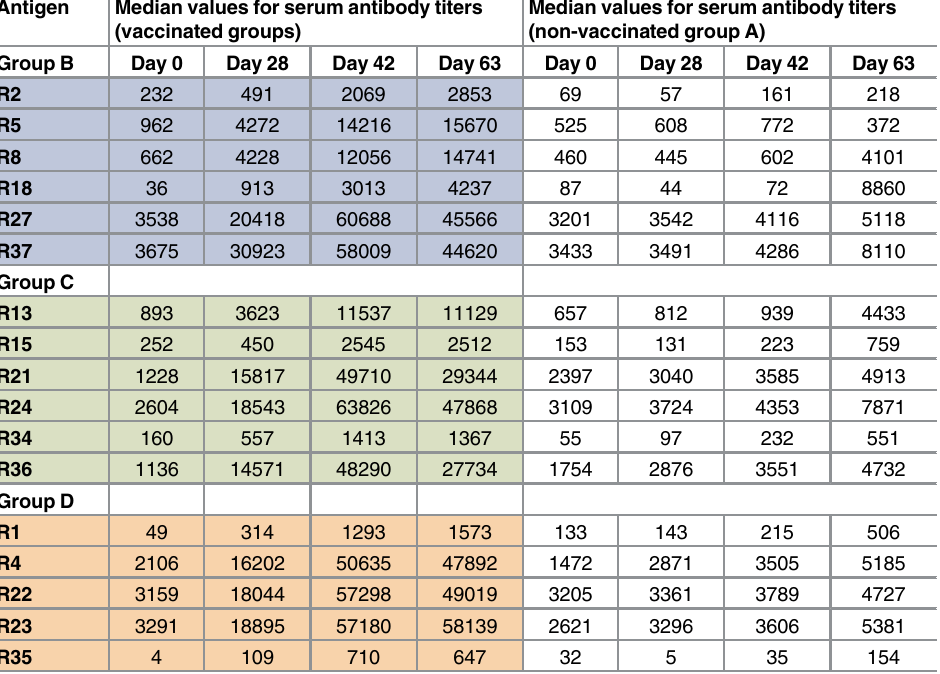
Table 3. Serological response to vaccination. Median values for serum antibody titers taken prior to vacci- nation (day 0), at the time of boost (day 28), immediately prior to H . somni bacterial challenge (day 42) and immediately prior to euthanization (day 63). “ R ” is denoted for rank of gene or protein. The vaccine for group A (placebo/control group) did not contain antigens. The vaccine for groups B, C and D contained antigens Antigen Median values for serum antibody titers Median values for serum antibody titers (vaccinated groups) (non-vaccinated group